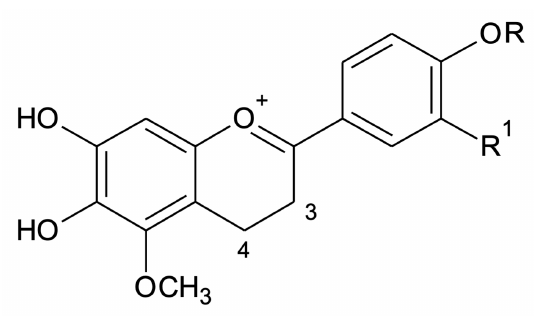
Figure 3. Proposed structures for A1 (C 16 H 15 O 6 , m / z 303.1922, R 1 = OH, R = H), A2 (C 17 H 17 O 6 , m / z 317.0756, R = CH3, R 1 = OH) and A3 (C 16 H 15 O 5 , m / z 287.0614, R = R 1 = H).